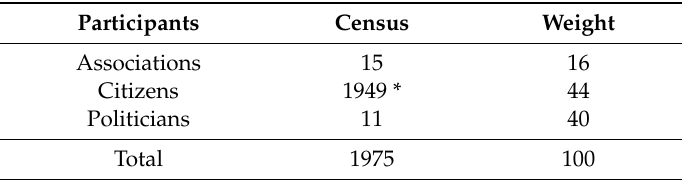
Table 1. Voters and